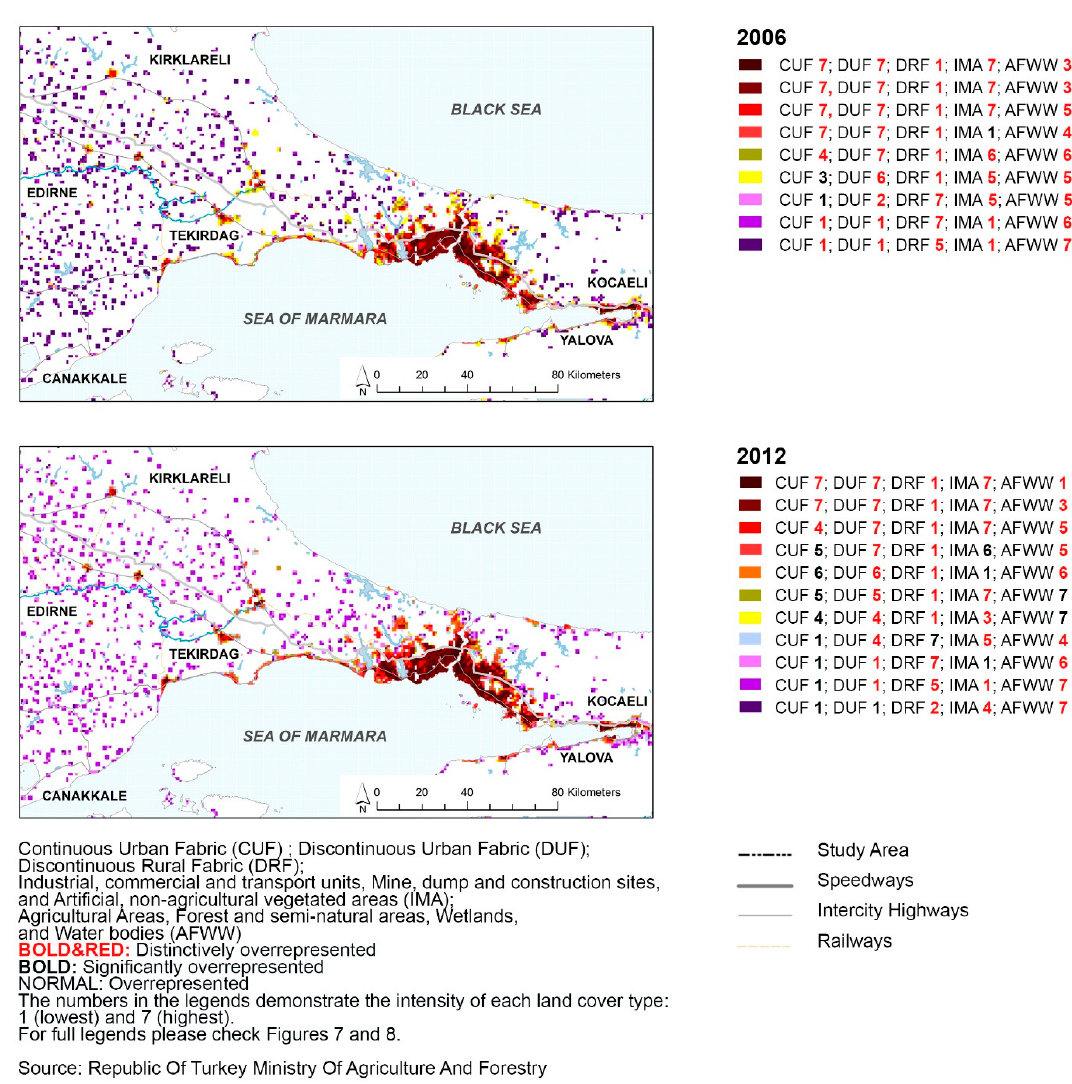
Figure 9. Urban fabric land cover comparison of Thrace and Istanbul for 2006 and 2012.